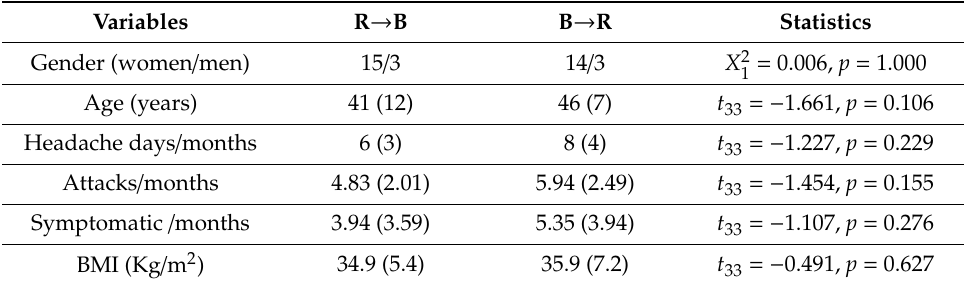
= 0.006, p = 1.000 1